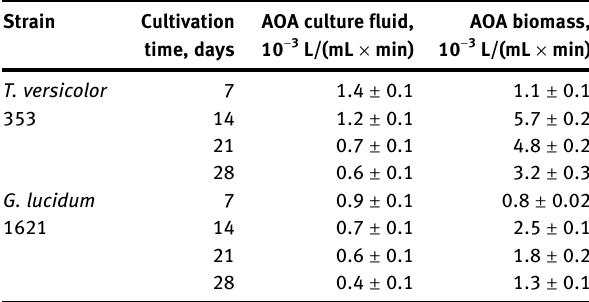
Each value is the mean of three observations (p<  .  ).